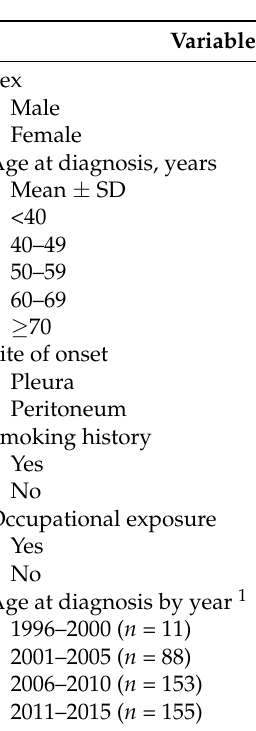
Table 1. General characteristics of study subjects ( n =